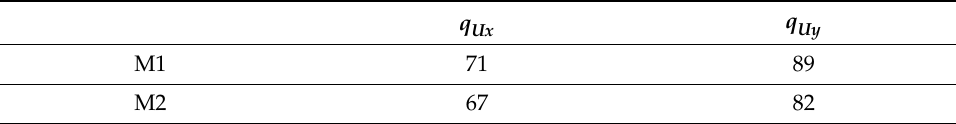
Figure 8. Illustration of the hit ratio for case M2 ( a ) at 2 m height over ground, ( b ) at 8 m height over ground. Table 3. Hit ratio for the whole domain of case M1 and